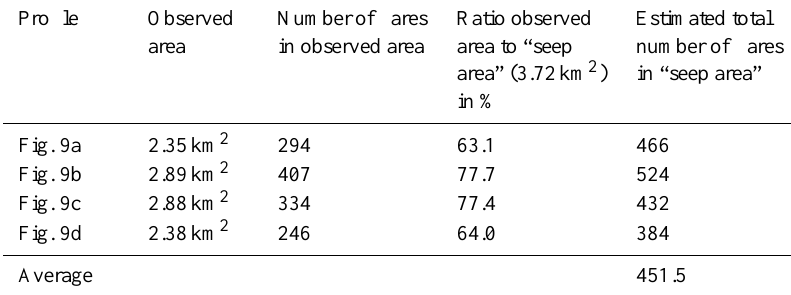
Table 4. Estimated number of flares in Area 3 following the approach described in the text and illustrated in Fig. 9.